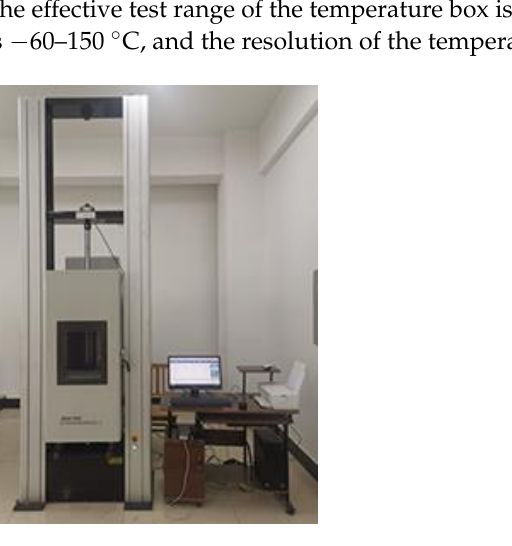
Figure 1. The YG028HS electronic machine with controlled temperature .